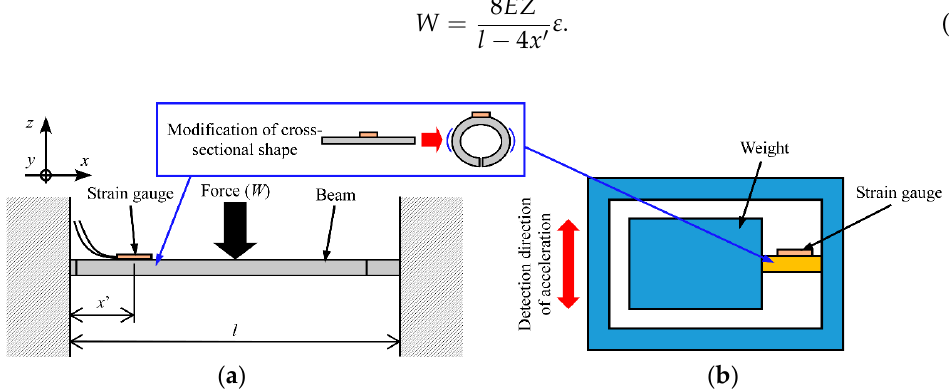
Figure 4. Applications of structural modification to ( a ) FS consisting of beam fixed at both ends and ( b ) accelerometer.